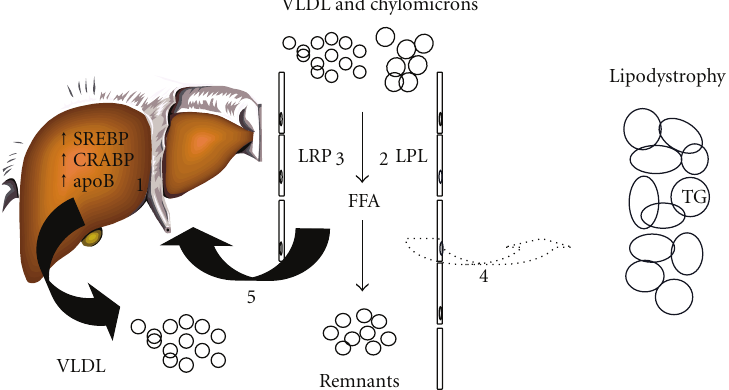
Figure 2: Pathogenesis of CART-related hyperlipidemia. Several factors contribute to hyperlipidemia in HIV-infected patients. PIs suppress the breakdown of the nuclear form of SREBP-1, as well as the proteasomal degradation of nascent apoB in the liver, leading to increased VLDL secretion (1). In the postprandial phase due to limited LPL availability, competition at the level of LPL will occur resulting in accumulation of TRL. This competition is most likely when fasting hypertriglyceridemia is present. In addition, impaired disposal of TRL is likely due to a defect in LPL activity (2) and delayed removal of remnant particles by liver receptors (3). Impaired FFA storage capacity (4) may lead to increased flux of circulating lipids (5) and upregulate hepatic VLDL production in patients with